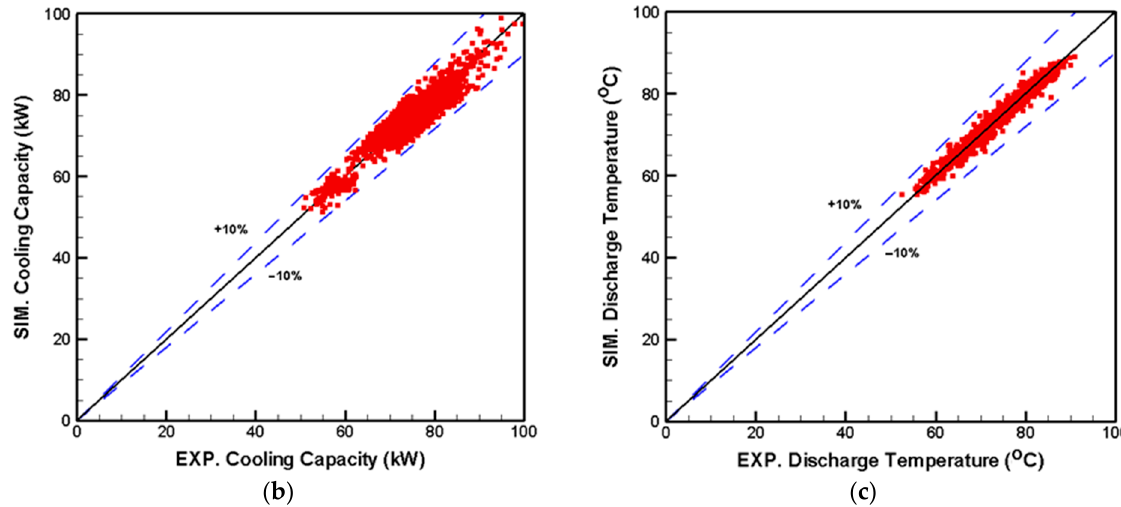
Figure 9. Validation of the ( a ) COP, ( b ) cooling capacity, and ( c ) discharge temperature at MT application.